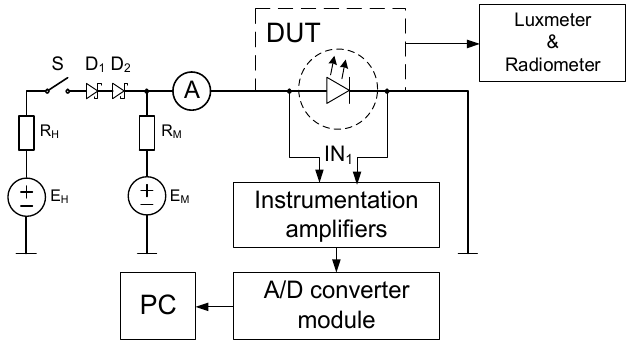
Figure 4. Diagram of the measuring set-up dedicated to a single diode.